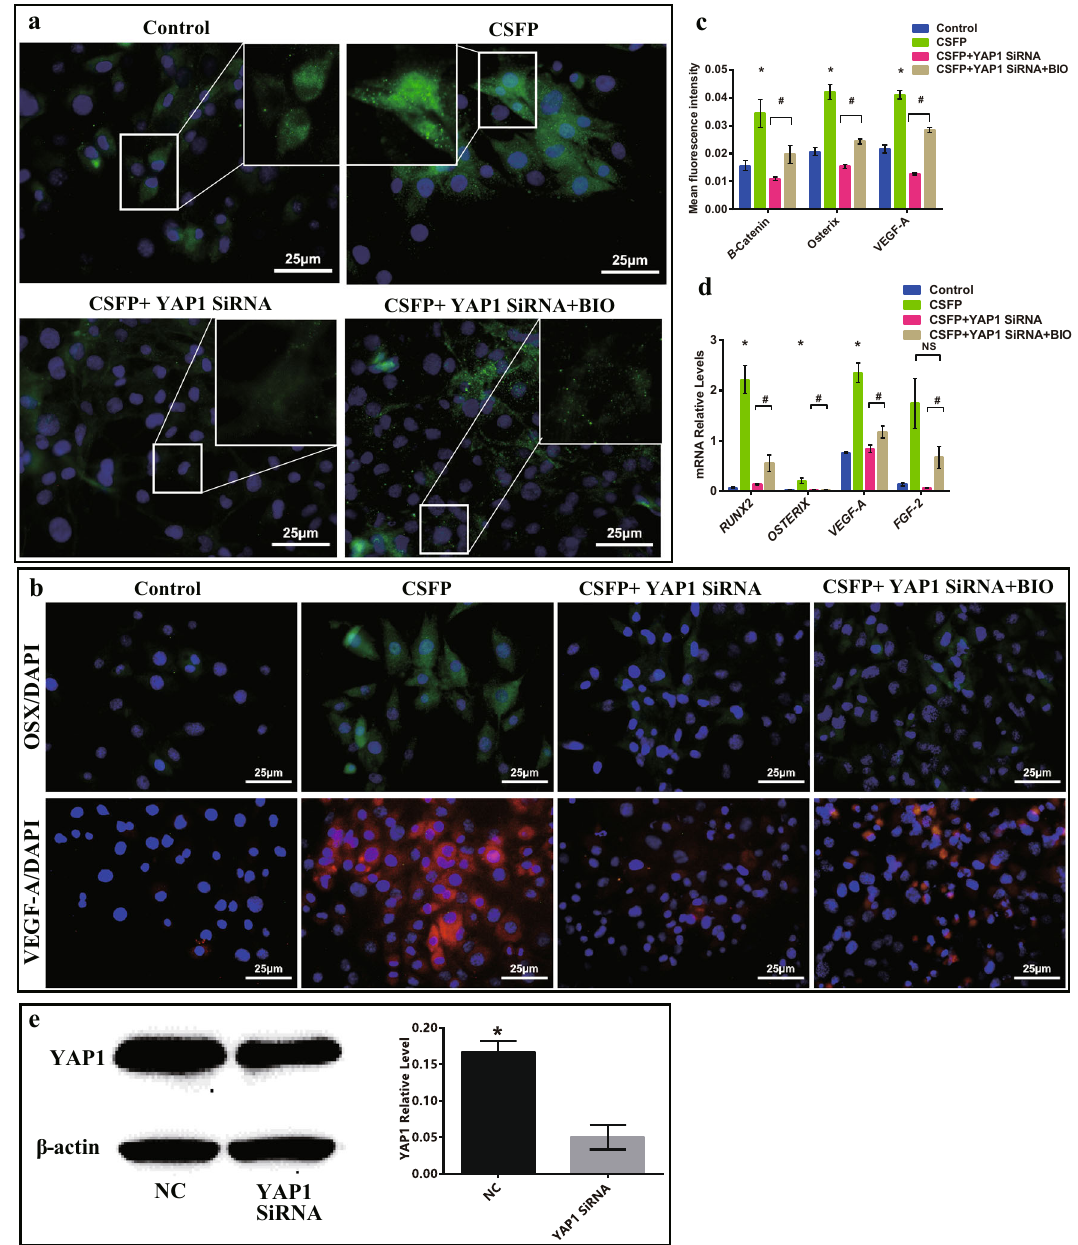
Fig. 9 CSFP promoted the osteogenic and angiogenic abilities of MSC through the YAP1/ β -Catenin axis. a IF staining revealed YAP-1 knockdown inhibited the expression and nuclear translocation of β -Catenin, and treatment with GSK-3 β inhibitor recovered the β -Catenin expression. b IF staining revealed YAP-1 knockdown inhibited the expression of Osterix and VEGF-A, and treatment with BIO recovered their expressions. c The mean fl uorescence intensity of β -Catenin, Osterix, and VEGF-A. d QRT-PCR analysis. e YAP1 mRNA and YAP1 protein expression levels in the normal control (NC) and YAP1-knockdown (YAP1 siRNA) cell models. Data are presented as mean ± SEM, and * P < 0.05. # P < 0.05 (CSFP + YAP1 siRNA group vs CSFP + YAP1 siRNA + BIO Red phalloidin staining polyclonal (1:100), CD31 rabbit monoclonal (1:500, Severicebio, Wuhan, China), Rabbit IgG monoclonal isotype control (1:200, Abcam, MA, USA), Cytoskeleton of MSC was stained with Acti-stain 555 Fluorescent Phalloidin Alexa Fluor ® 647 conjugated Goat Anti-Mouse IgG (1:100), Alexa Fluor ® 488 (Cytoskeleton, CO, USA, 1:500) according to the manufacturer ’ s instructions. conjugated Goat Anti-Mouse IgG (1:100, Abcam, MA, USA), Cy5 conjugated Goat Anti-rabbit IgG (1:100), Alexa Fluor ® 488-conjugated Goat Anti-Rabbit IgG (1:100), Cy3 conjugated Goat Anti-Rabbit IgG (1:100, Severicebio), and Immuno fl uorescence Immuno fl uorescence was performed as previously described 10 . The following antibodies were used: β -Catenin mouse monoclonal (1:100), YAP1 mouse monoclonal (1:100), Runx2 mouse monoclonal (1:200), Osterix mouse monoclonal (1:500), VEGF-A mouse monoclonal (1:100), mouse IgG 1 -FITC isotype control (1:200, Santa Cruz, CA, USA), β -Catenin rabbit